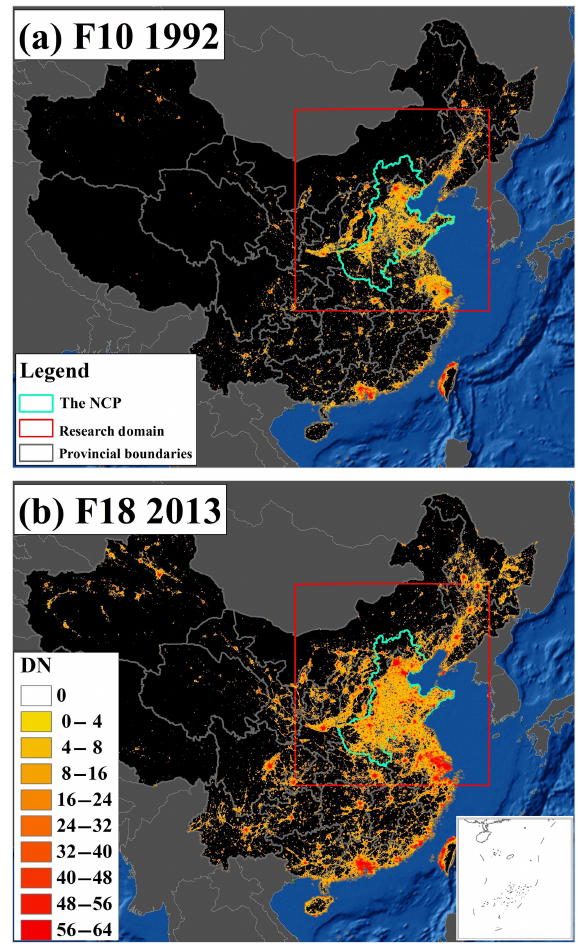
Figure 1. The spatial distributions of the nighttime-light data (NLT) from DMSP/OLS DN values in (a) 1992 and in (b)